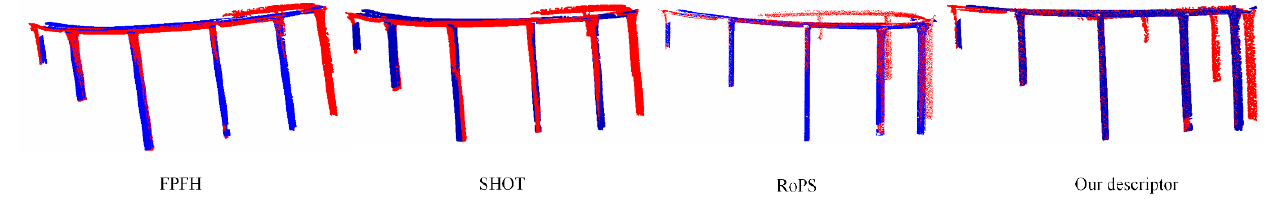
Figure 11. PCR result of Sujiaba Bridge based on four methods. From left to right is the result of FPFH, SHOT, RoPS, and our descriptors, respectively. The source point cloud is shown in blue, and the target point cloud is shown in red.